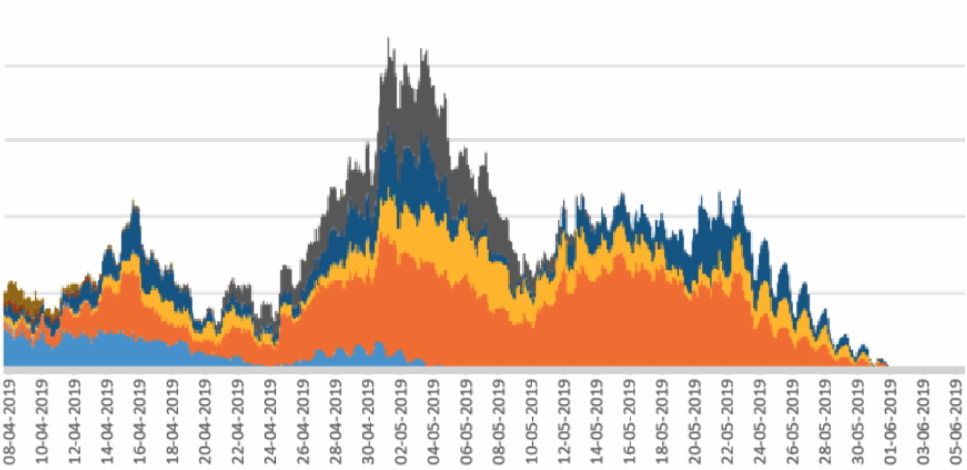
Figure 7. Stacked line graph for aligned periodicity intensities for calves 6–15. Each colour represents a different calf.